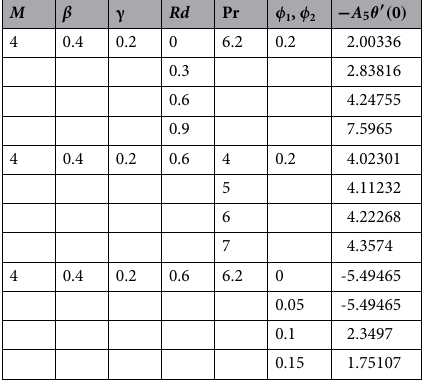
Table 4. Numerical values of Nusselt number − A 5 θ ′ ( 0 ) .